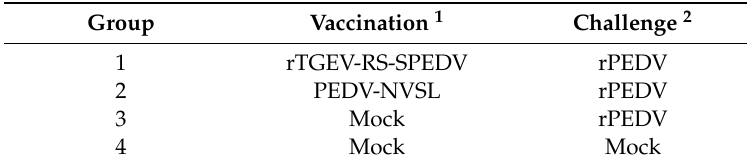
Table 1. Animal groups in the protection experiment; 21-day old piglets were randomly assigned to four di ff erent